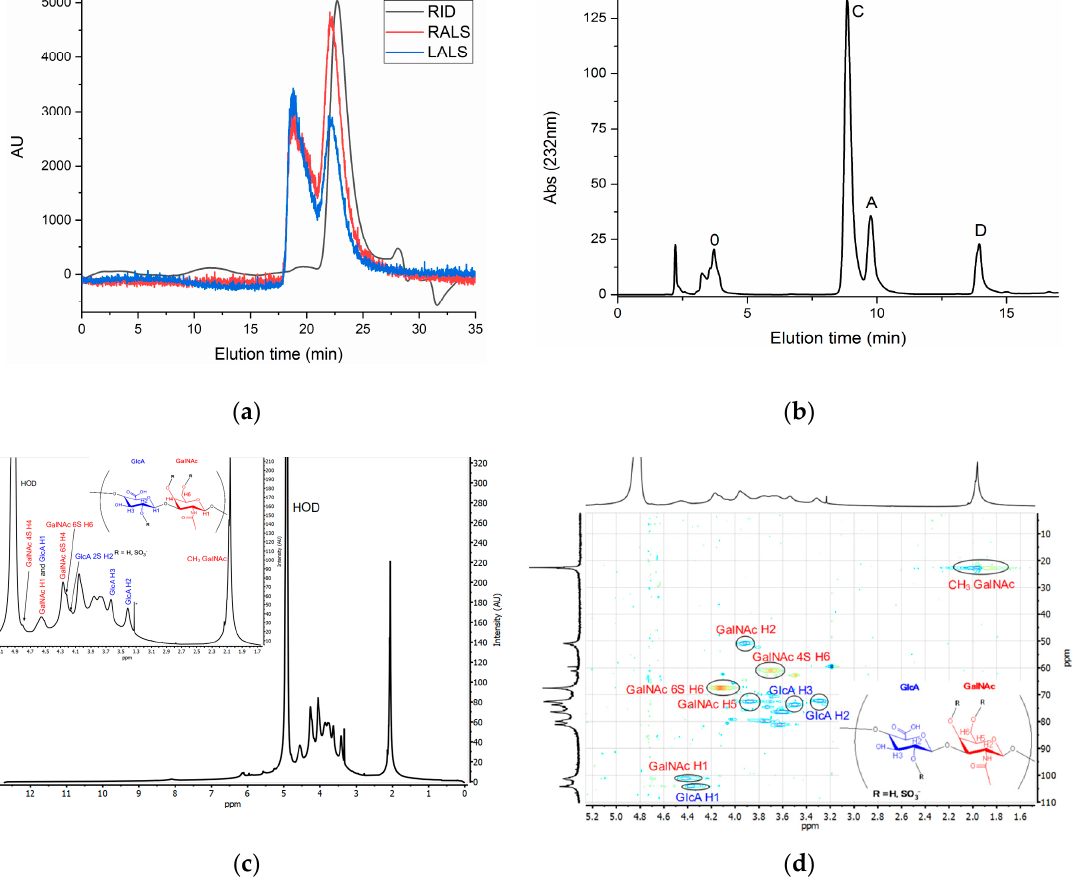
Figure 3. ( a )—Gel Permeation Chromatography (GPC) eluograms of CS extracted from P . glauca. Red line: right angle light scattering signal (RALS); Blue line: low angle light scattering signal (RALS); Black line: refractive index (RID) signal; AU: arbitrary units. ( b )—SAX-HPLC chromatogram of CS from from P . glauca after enzymatic digestion with chondroitinase ABC. 0: Δ UA-GalNAc; A: Δ UA-GalNAc(4S); C: Δ UA-GalNAc(6S); D: Δ UA(2S)-GalNAc(6S). Full 1 H NMR with expansion of region with CS signals ( c ) and HSQC ( d ) spectra of CS extracted from P . glauca in D 2 O recorded at 10 °C. Table 3. Molecular weight and disaccharide composition of CS from P. glauca . M n : number average molecular weight, PDI: polydispersity index ( M w / M n ); Disaccharide composition expressed as mean % ± standard deviation (n = 2).